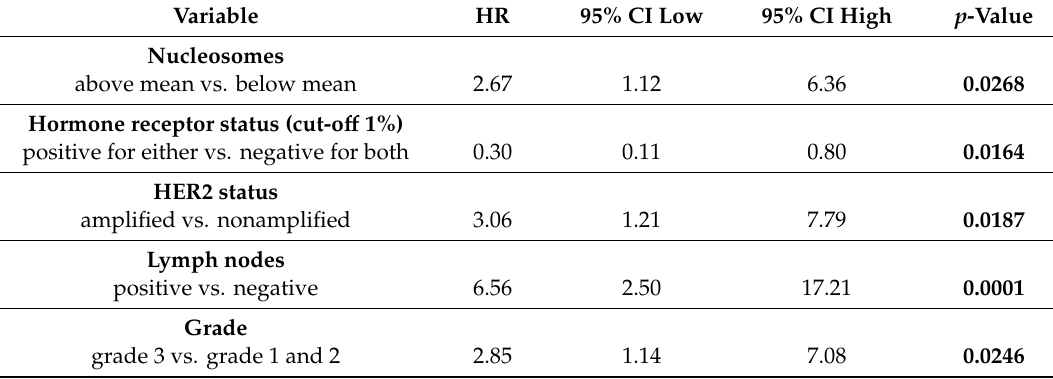
Table 6. Multivariate analysis of factors associated with disease-free